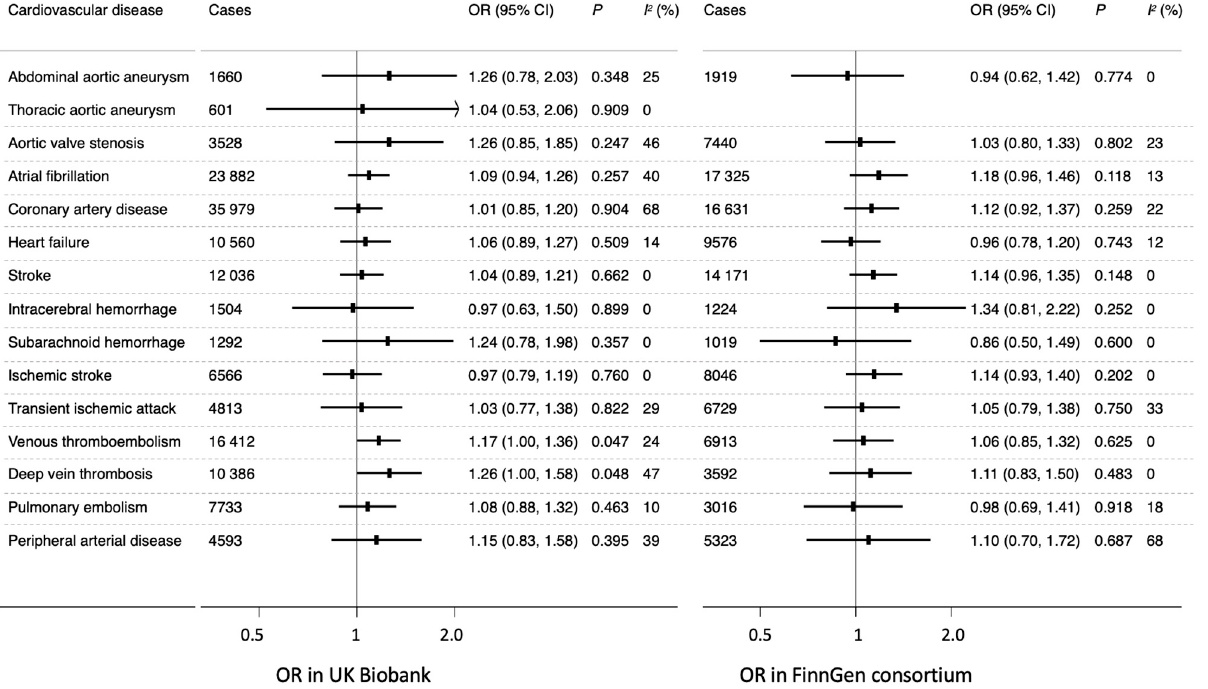
Figure 1. Associations between genetically predicted coffee consumption and cardiovascular diseases. CI indicates confidence interval; OR, odds ratio. The I 2 statistic represents heterogeneity across estimates of used SNPs. Aortic aneurysm includes abdominal and thoracic aortic aneurysm in FinnGen. Data for non-rheumatic valve diseases was used to replicate the association for aortic valve stenosis in FinnGen.